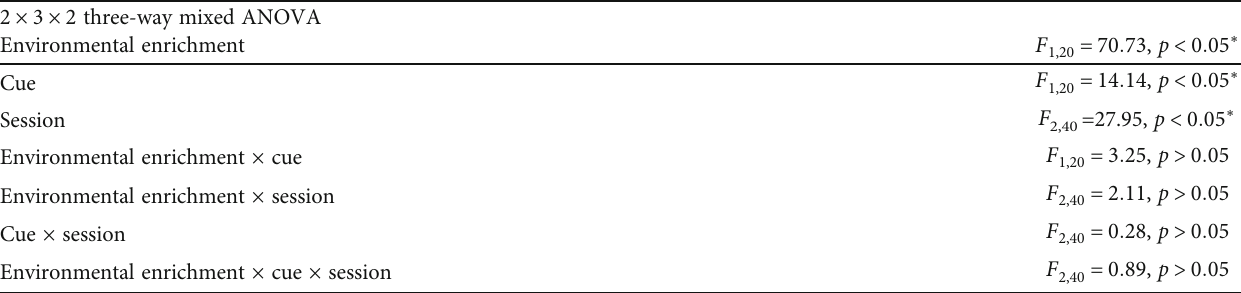
Table 1: Mean ( ± SEM) freezing time (sec.) was analyzed by a 2 × 2 × 3 three-way mixed analysis of variance (ANOVA) (environmental enrichment vs. cue vs.